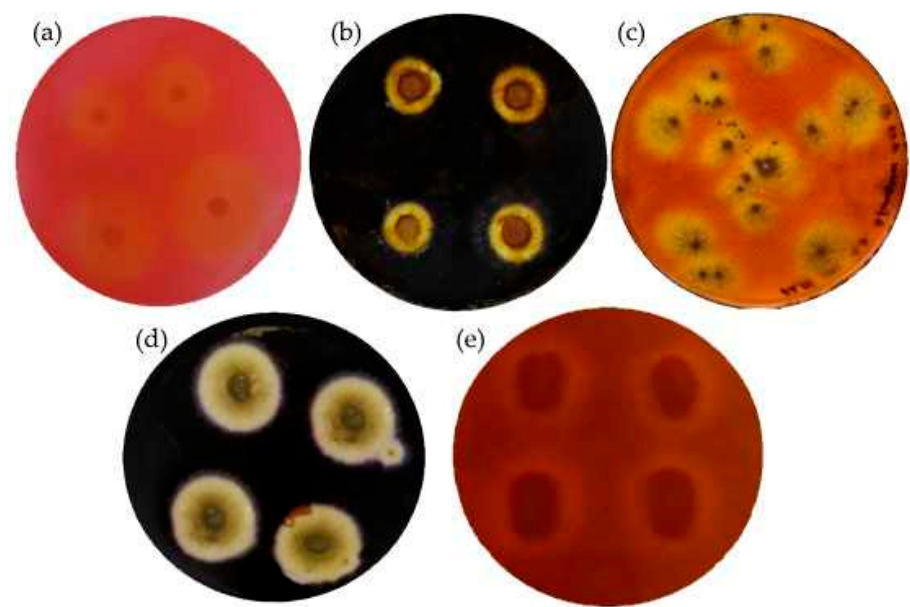
Figure 3. Detection of enzymatic activities from the isolated fungal strain by floating Petri dishes with Congo red for cellulase activity and Gram iodine solution for amylase activity, respectively: ( a ) Rh. oryzae after 12 days of growth with Congo red, ( b ) Rh. oryzae after 4 days of growth with Gram iodine, ( c ) A. fumigatus after 7 days of growth with Congo red, ( d ) A. fumigatus after 7 days of growth with Gram iodine, ( e ) P. putida after 14 days of growth with Congo red.